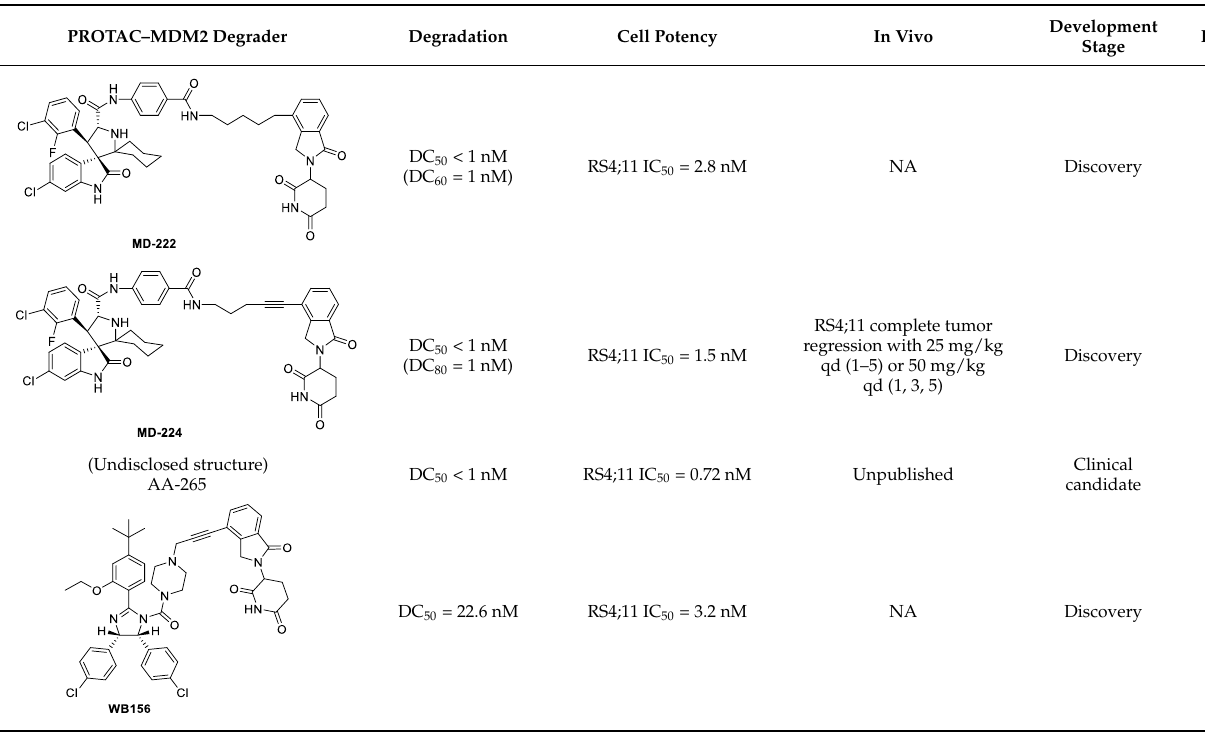
Table 2. PROTAC–MDM2 degraders.